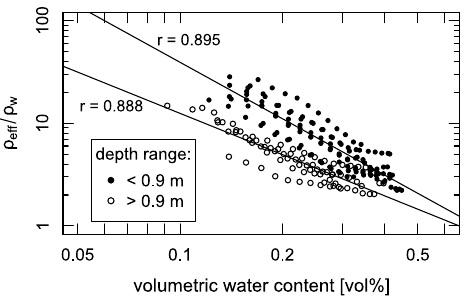
Figure 3. Volumetric water content in dependence of resistivity ra- tio ( ρ eff /ρ w ) for two different depth